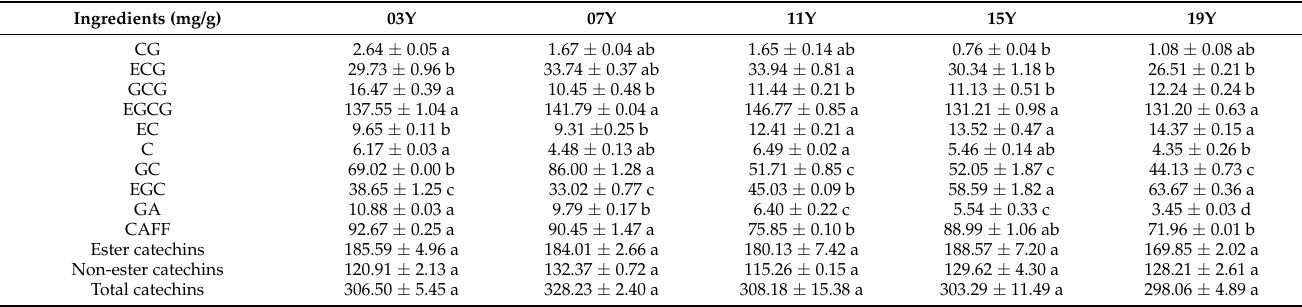
Table 2. Quantitative analysis of catechins, gallic acids and caffeines in the extract of the aged Chinese green tea (HSGT)